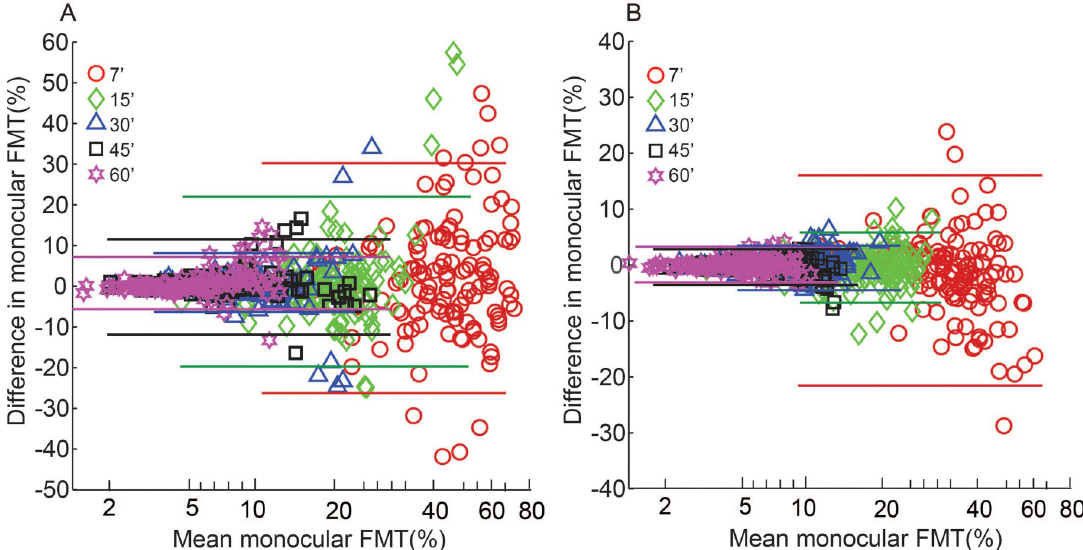
Fig 2. Bland-Altman type plots of intersession difference. Monocular FMTs are plotted as a function of the corresponding mean FMT for different target sizes under mesopic (panel A) and photopic (panel B) viewing conditions. Different colored solid horizontal lines indicate ± 95% limits of agreement in FMT between sessions for the respective target sizes,